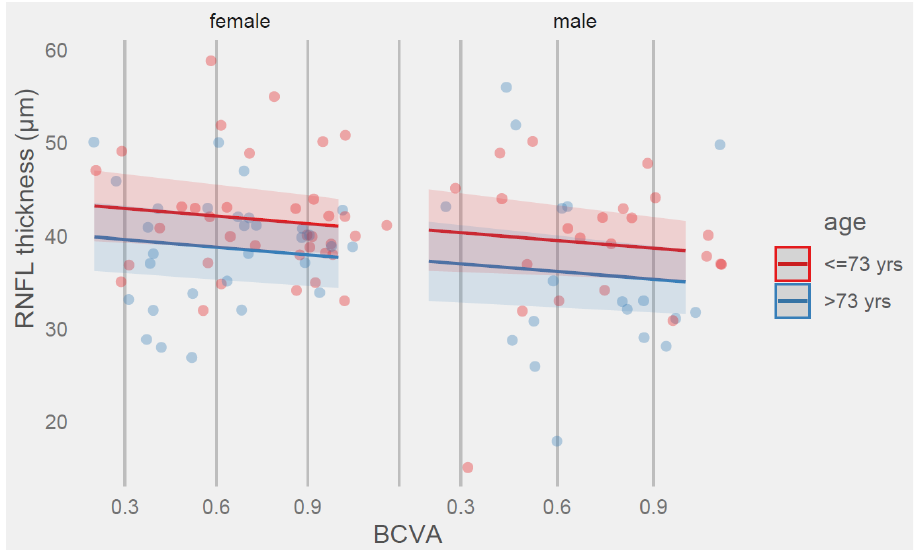
Figure 3. Prediction of RNFL thickness values ( µ m) by model 3 with BCVA, age, and sex terms. Predictions for RNFL thickness based on the BCVA lower and upper sample size range {0.2, 1.0} within age and sex variables are shown in Table 4. It shows that the difference between age groups in RNFL thickness was more than 3 µ